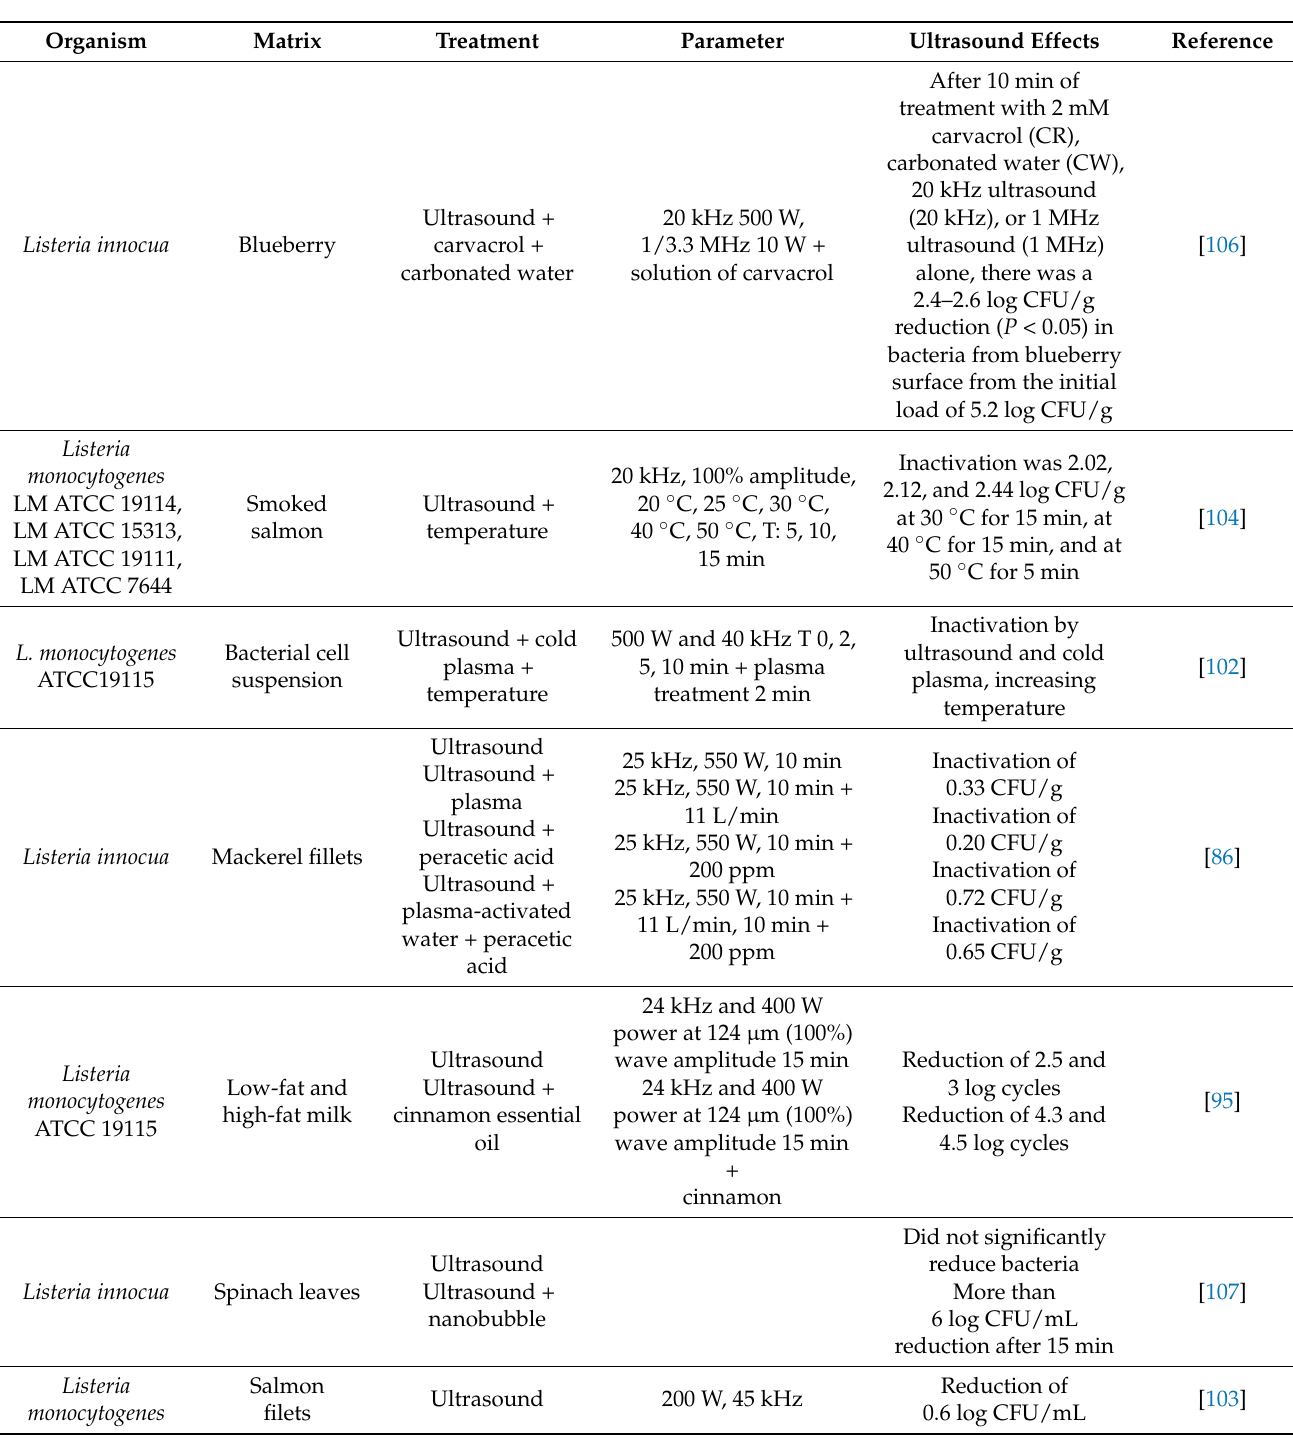
Table 4. Ultrasound effects as single or combined non-thermal technology: Listeria